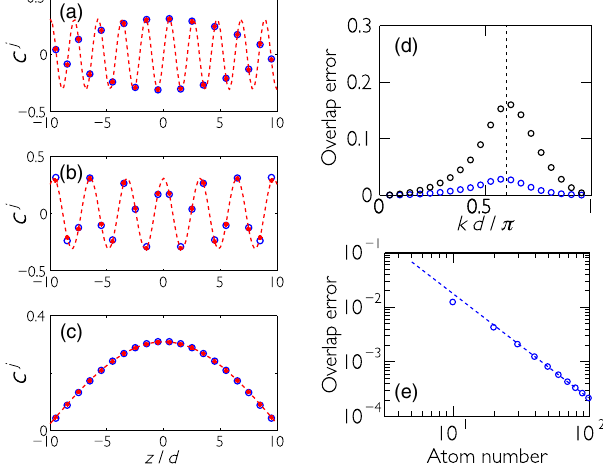
FIG. 4. Comparison between ansatz of Eq. (11) and exact single-excitation eigenstates in an atomic 1D chain. Here, we identify a selected number of modes based upon their dominant wave vector k , and compare the spatial wave-function coefficients c j with an ansatz built from the same wave vector: (a) kd ¼ π N= ð N þ 1 Þ (most subradiant state), (b) k ∼ k 0 (close to light line), and (c) kd ¼ π = ð N þ 1 Þ (most radiant state), for parallel atomic polarization. Blue and red circles denote the coefficients of the exact state and ansatz, respectively, while the dashed red line z Þ or sin ð k z Þ associated with each indicates the function cos ð k n n mode. (d) Error in overlap ε between exact state and ansatz as a function of k , for parallel (blue) and transverse (black) atomic polarization. The error decreases far from the light line (denoted by black dashed line). (e) Scaling of ε with particle number N for the most subradiant state. The lattice constant is set to d= λ 0 ¼ 0 . 3 and [except in (e)] N ¼ 20